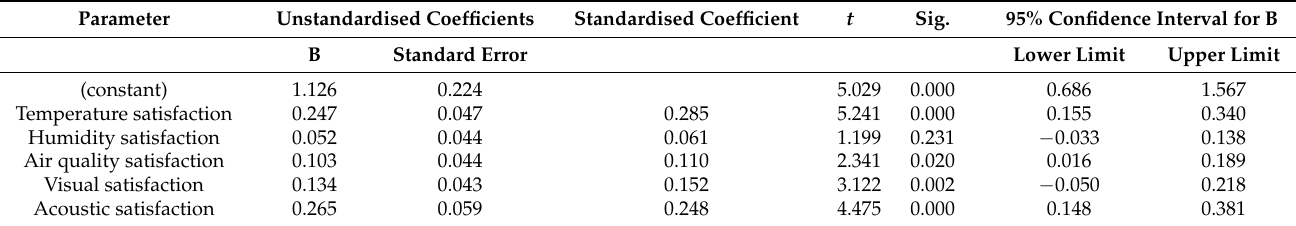
Table 11. Results of multiple regression analysis.